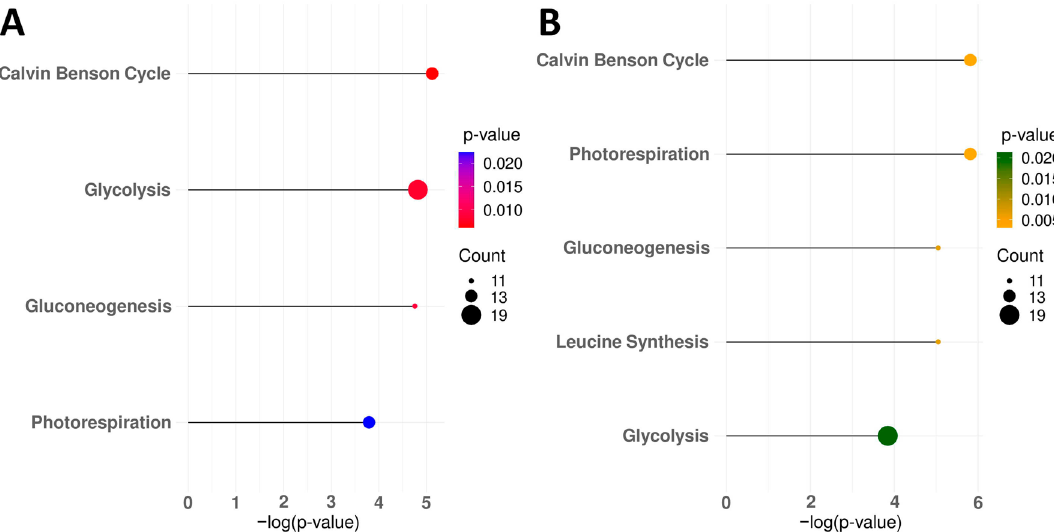
Figure 4. Pathways enriched in reactions with highly altered fluxes. Displayed are pathways significantly ( P < = 0.05 ) enriched in regulated reactions based on ( A ) relative and ( B ) nominal differences. They are descending ordered according to their respective P -value. Size of the dots corresponds to the count of reactions present in the pathway. Bar size represents the negative logarithm of the P -value